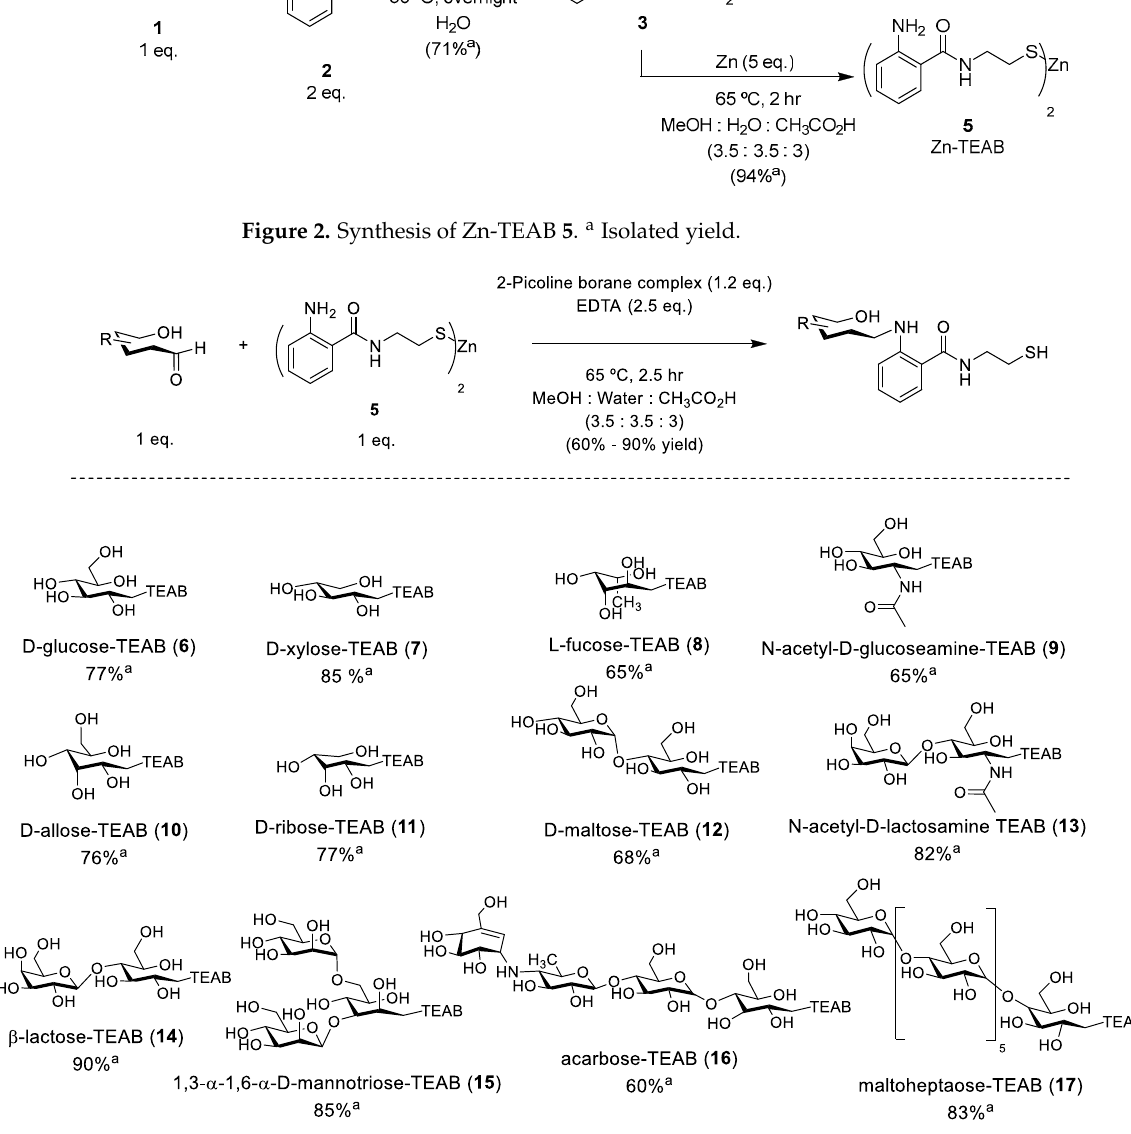
Figure 3. General synthesis of model TEAB-linked glycans. a Isolated yield.